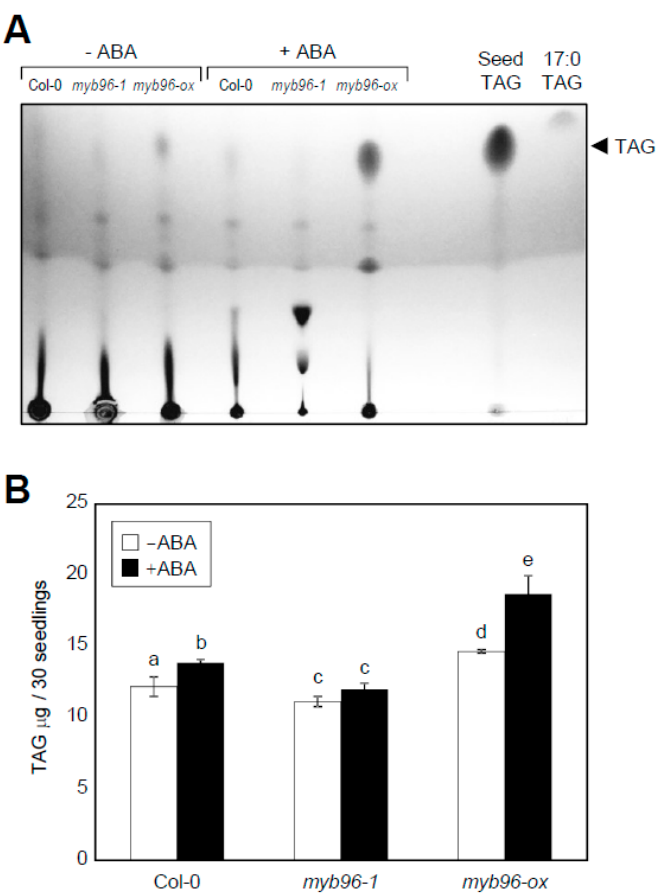
Figure 3. Effects of ABA on TAG accumulation in myb96-ox and myb96-1 . Five-day-old seedlings grown under LD conditions were transferred to MS–medium supplemented with 10 μ M ABA and incubated for additional 2 days. Total lipids were extracted and separated in TLC plates. ( A ) Separation of total lipids by TLC. Three independent experiments with three biological replicates were analyzed, and representative images are shown. TAG from wild-type seeds and 17:0 TAG standard were loaded on the right of the plate to indicate positions of the lipids. ( B ) Quantification of TAG by gas chromatography (GC) analysis. Three independent experiments with three biological replicates were averaged. Bars indicate the standard error of the mean. Different letters represent a significant difference at P < 0.05 (one-way ANOVA with a Fisher’s post hoc test).